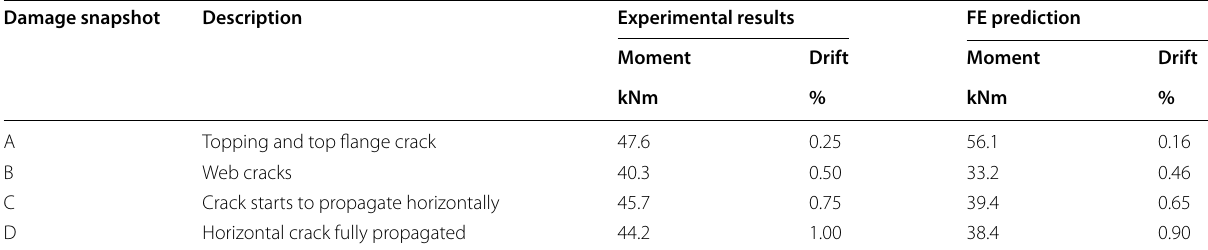
Table 2 Negative moment and associated drift values at different instants of the damage progression Damage snapshot Description Experimental results FE prediction Moment Drift Moment